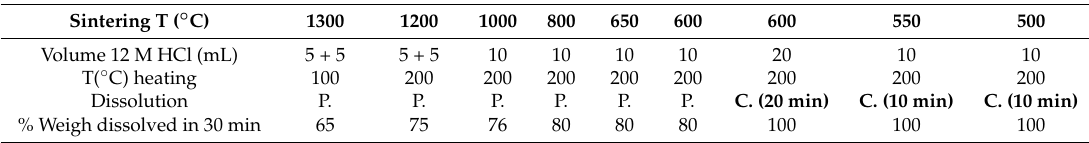
Table 8. Dissolution of target.